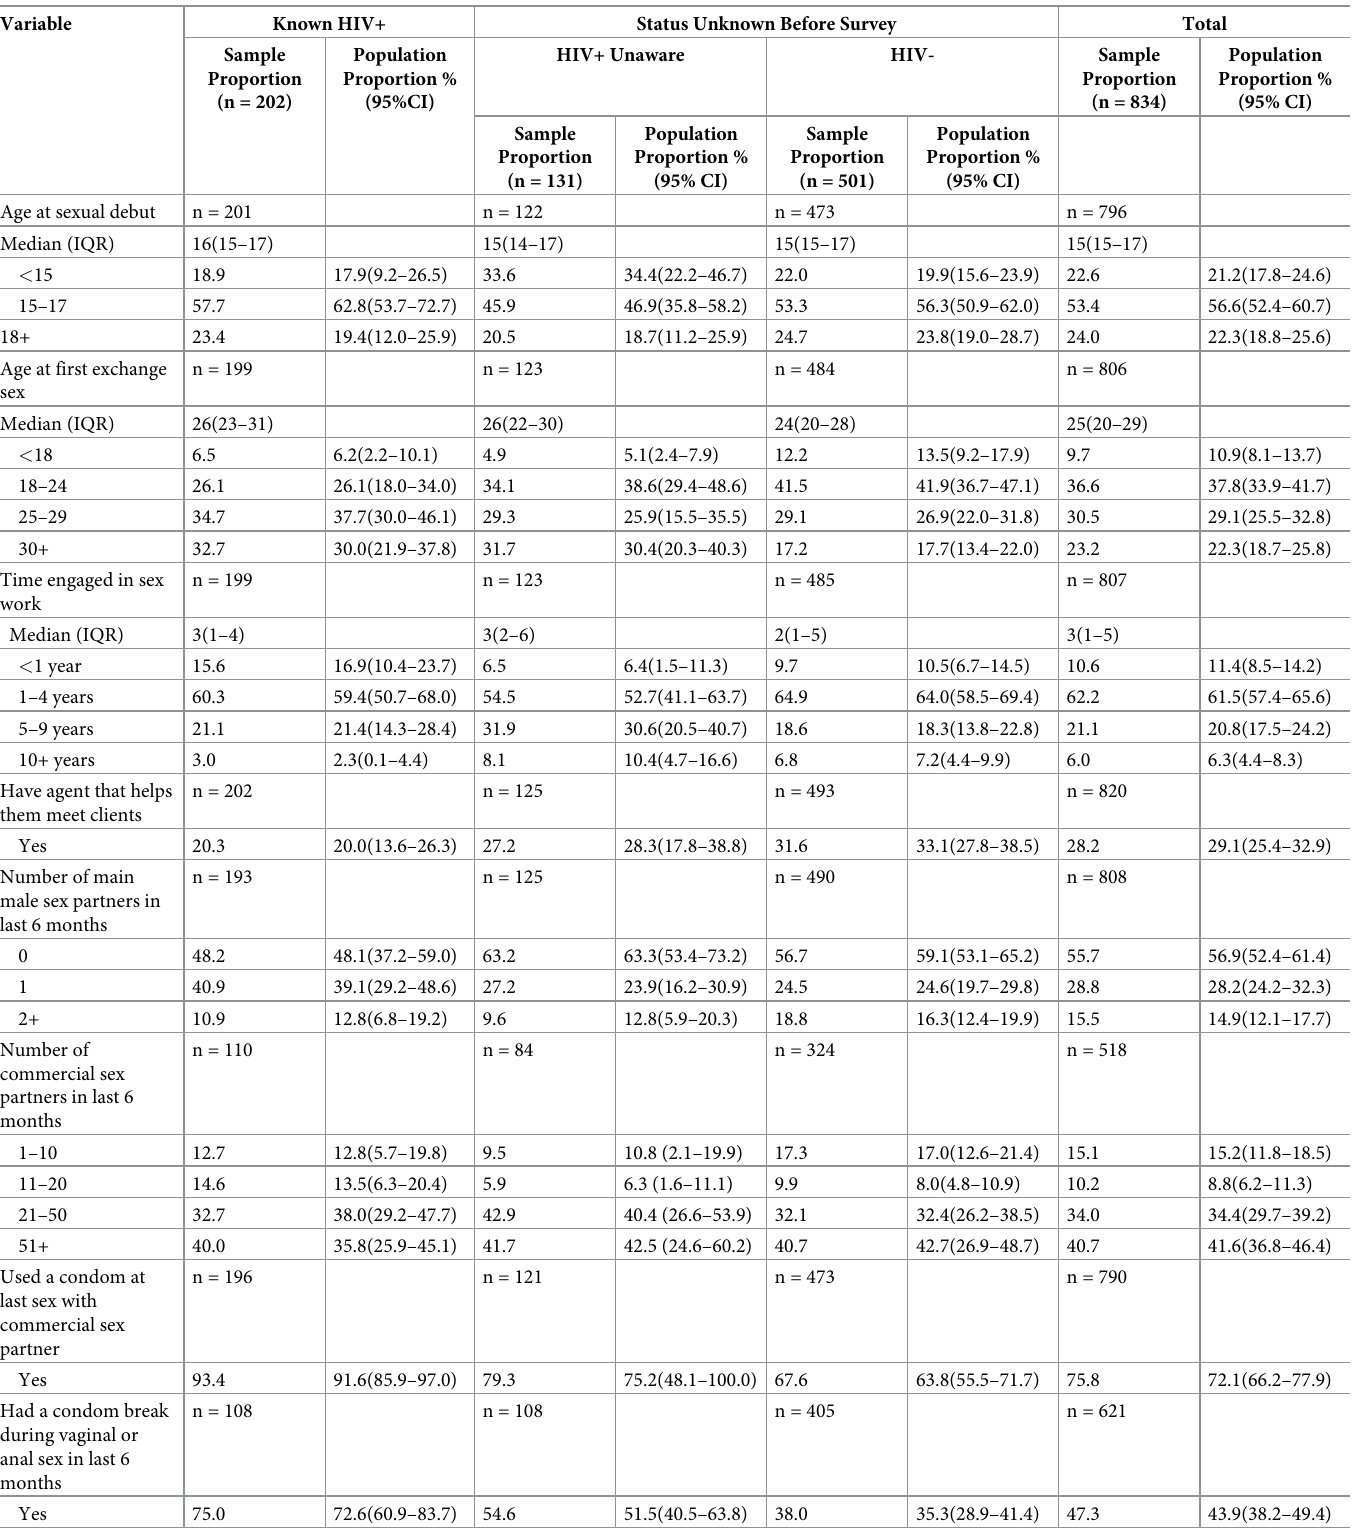
Table 2. Sex work characteristics among FSW in Juba, South Sudan